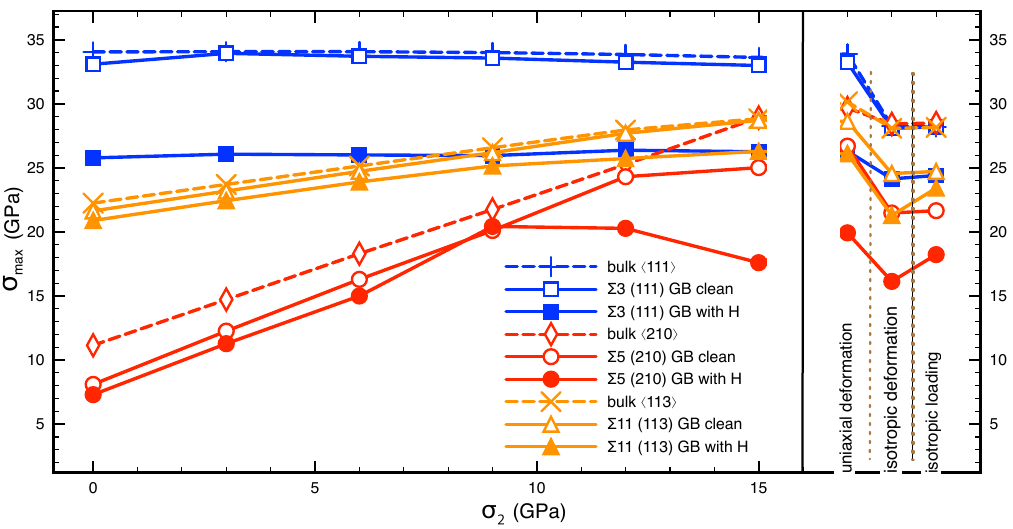
Figure 6. Computed values of the cohesive strength σ max for the bulk crystal (symbols connected by dashed lines), clean GB (open symbols, solid lines), and H-charged GB (solid symbols, solid lines). The left panel shows σ max as a function of one of the transverse stresses ( σ 2 ) during triaxial loading. The right panel displays the σ max values computed for other specific loading types. Note that the data for σ 2 = 0 correspond to results of uniaxial